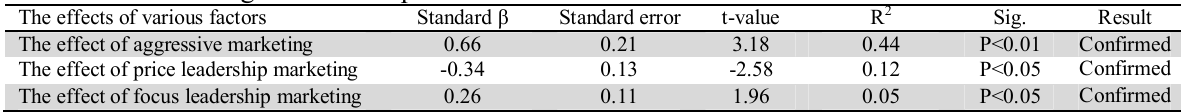
The results of testing various